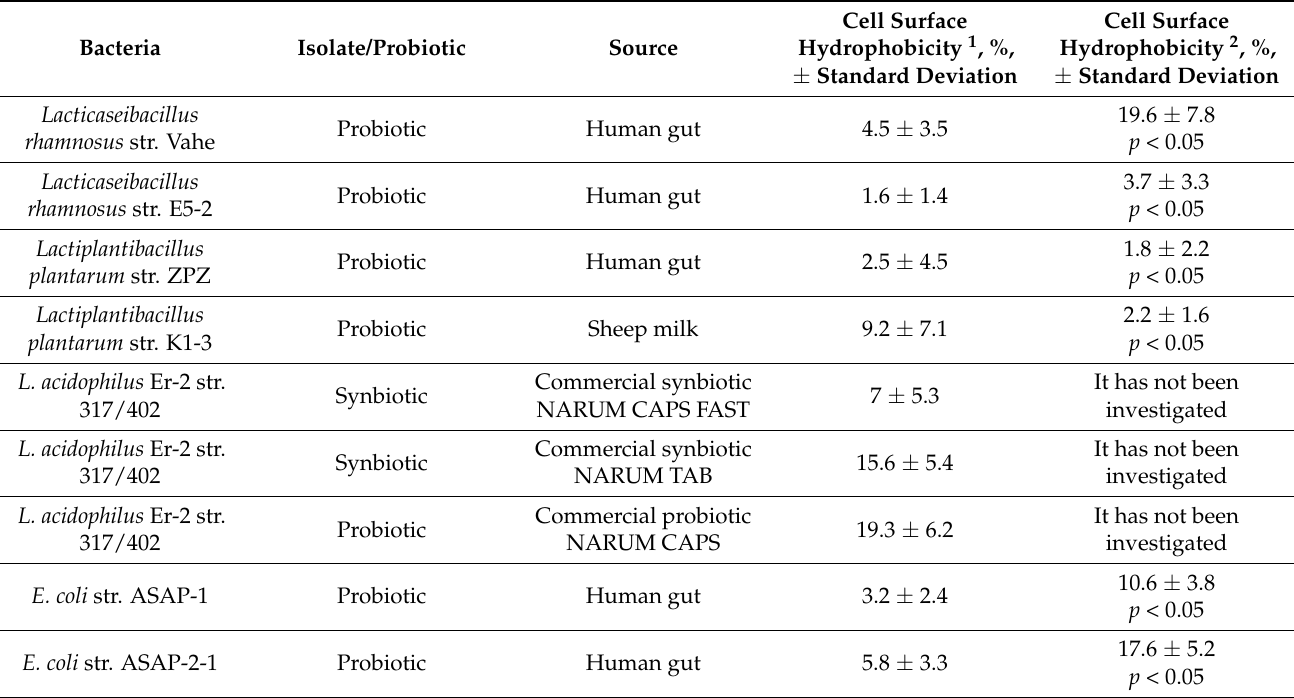
Table 2. Comparative characteristics of bacterial cell surface hydrophobicity levels in different growth